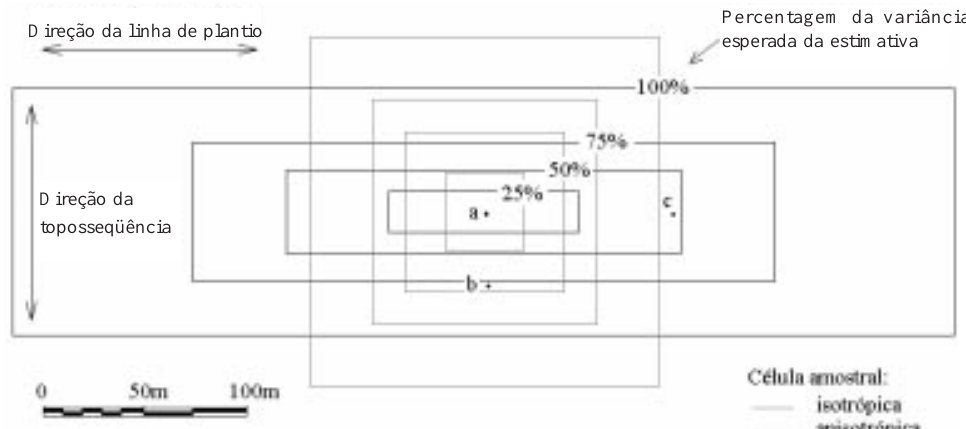
Figura 4. Redimensionamento da área de representatividade de amostras, considerando a variância esperada da estimativa, segundo os semivariogramas isotrópicos e anisotrópicos.